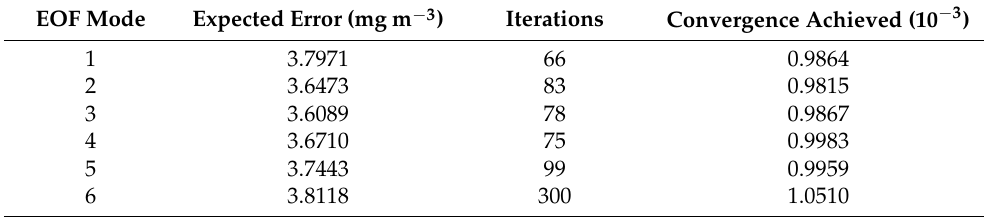
Table 3. The expected error with DINEOF for different EOF modes.